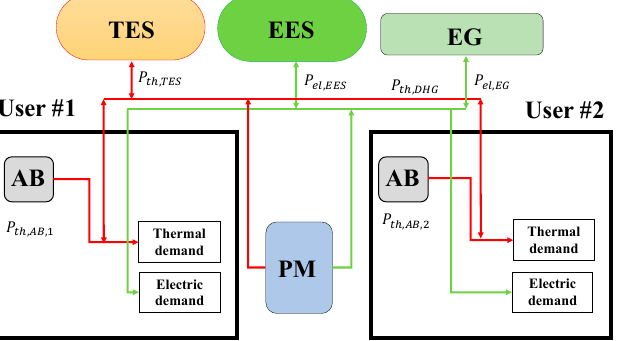
Figure 4. CHP scenario with shared TES, EES and PM.